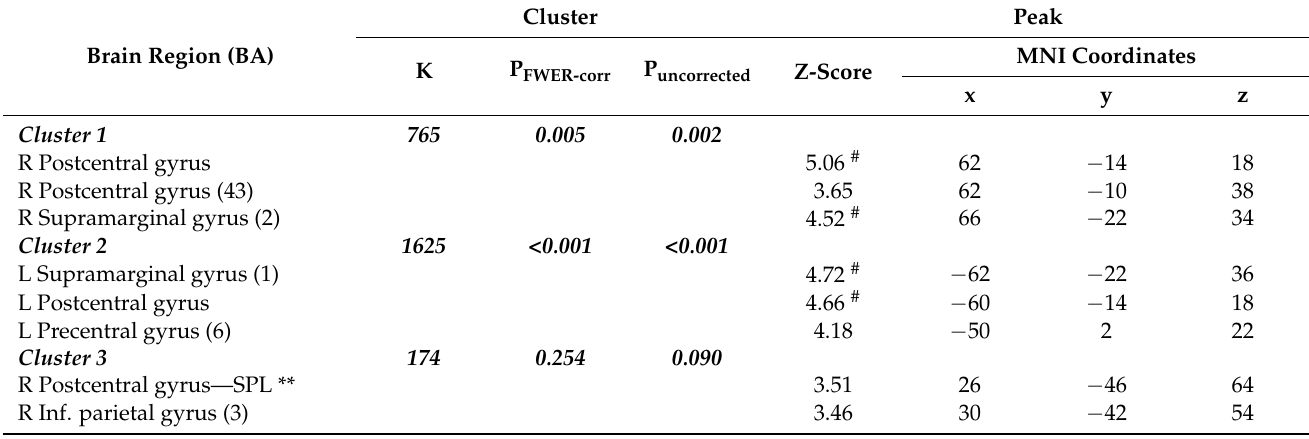
Figure 1. Between-group comparison: tactile stimulation task. Comparison between individuals with BID and healthy subjects. Brain regions more active in healthy subjects than in subjects with BID (linear t-contrast: healthy subjects vs. individuals with BID). The bar graphs (upper right and left graph) illustrate the contrast estimates—betas—and their 90% confidence intervals of the fMRI response in the left (MNI coordinate: x = − 60; y = − 14; z = 18) and right (MNI coordinate: x = 62; y = − 14; z = 18) postcentral gyrus respectively: these regions showed a decreased activity in participants with BID during the tactile stimulation of the body parts. Visualized at the voxelwise threshold of p < 0.001 uncorrected. Table 3. Between-group comparison: tactile stimulation task. MNI coordinates of the brain regions were significantly less active in subjects with BID than in healthy subjects during the tactile stimulation of the body parts (controls > participants with BID). Brain region (R = right hemisphere; L = left hemisphere), cluster size (k = number of voxels), cluster-wise FWER-corrected p -value and uncorrected p -value, voxel-wise (peak level) Z-score and Montreal Neurological Institute (MNI) coordinates are reported. # Statistical threshold p < 0.05 whole-brain FWER-corrected voxelwise (peak level). BA = Brodmann Areas; corr = corrected. Cluster 3 is reported because it corresponds to the superior parietal lobule of reduced connectivity and grey matter density of Saetta et al. [28]. The left precentral peak of cluster 2 includes the precentral area of reduced grey matter density reported in Saetta et al. [28]. ** brain regions identified by the Neuromorphometrics and the HarvardOxford